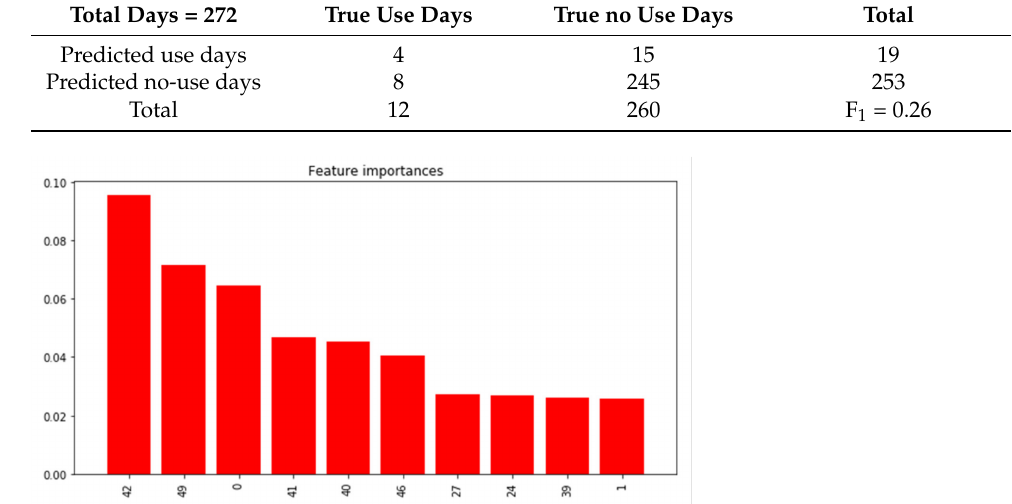
Figure 14. Feature importance for top-10 W-TSS shapelets predicting days with and without inhaler use in PRISMS.